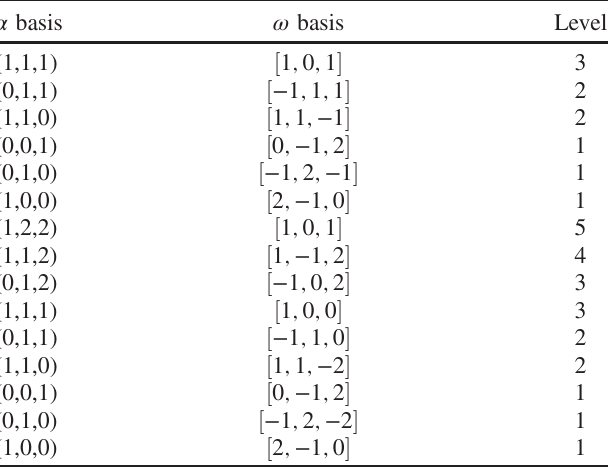
TABLE IV. Positive roots systems for Lie algebras A 3 ¼ su ð 4 Þ